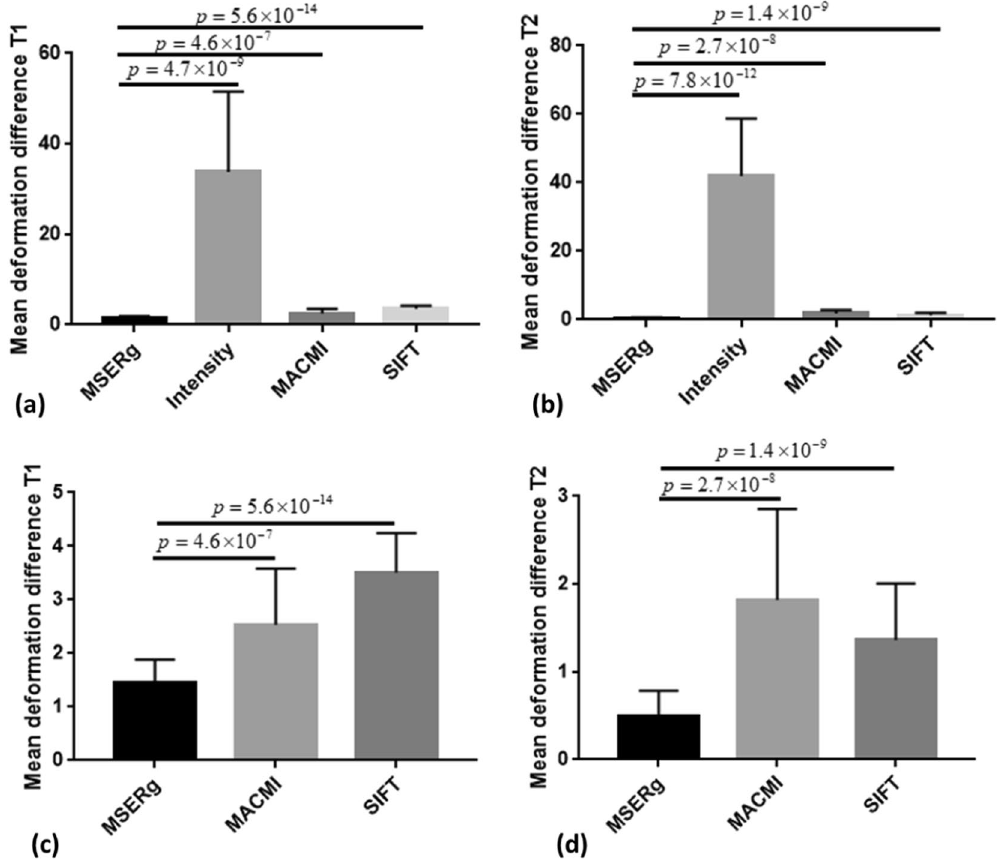
Figure 5. MSERg, MACMI, SIFT and Intensity-based Registration comparison in terms of MDD with statistical significance analysis on synthetic test set (25 cases of PD,T1 and T2 weighted MRI). Lower the MDD value indicates less difference between the recovered deformation and the induced deformation and thus a better registration result. ( a ) shows the registration results with PD images as fixed images and T1 weighted images as moving images and ( b ) with T2 weighted images as moving image. ( c ) and ( d ) exclude the intensity- based results to demonstrate comparison between MSERg, MACMI and SIFT methods more specifically. MSERg has the least MDD from the induced deformation compared with the other registration methods statistically